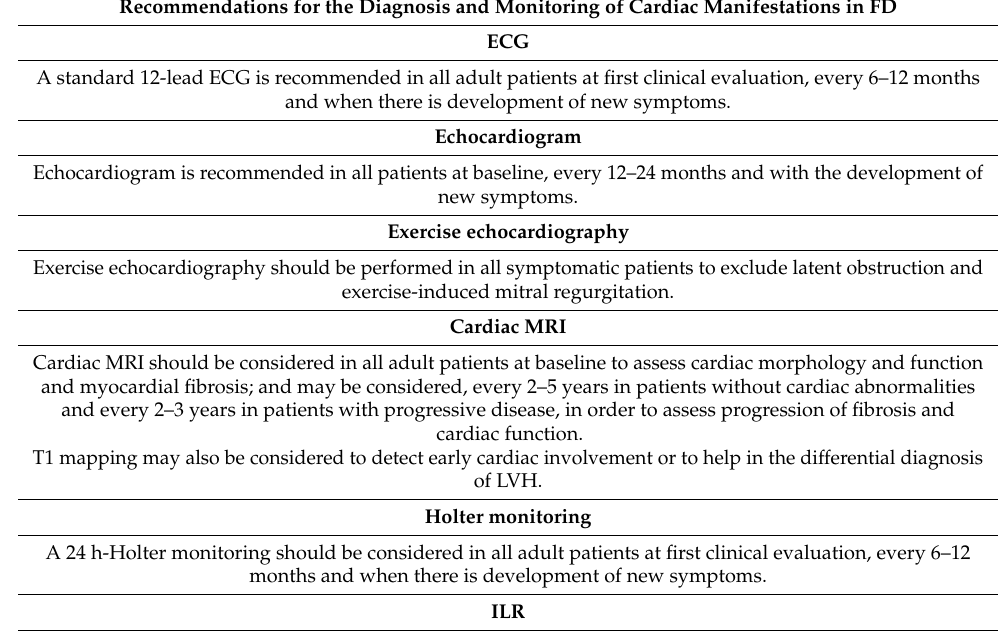
Table 6. Summary of the main recommendations for the diagnosis and monitoring of cardiac manifestations in FD